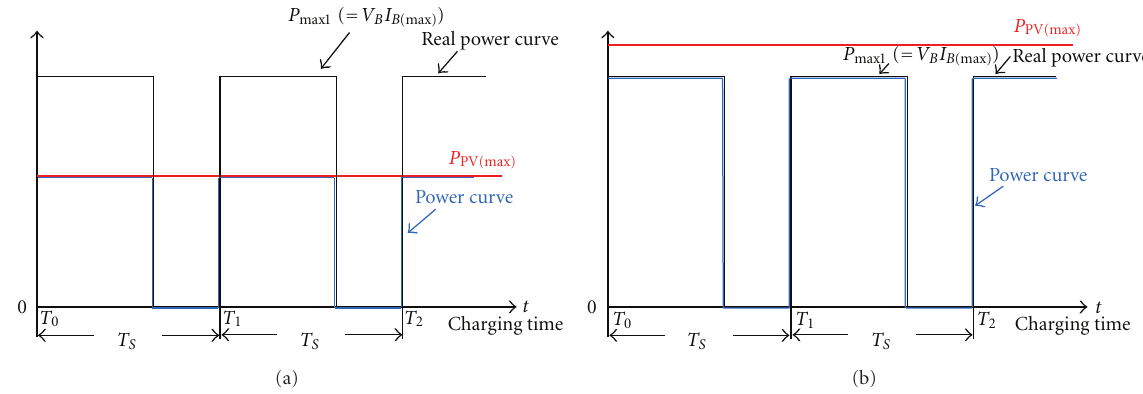
Figure 10: Conceptual power waveforms of PV arrays and battery charging power: (a) P PV(max) ≤ P max1 and (b) P PV(max) ≥ P max1